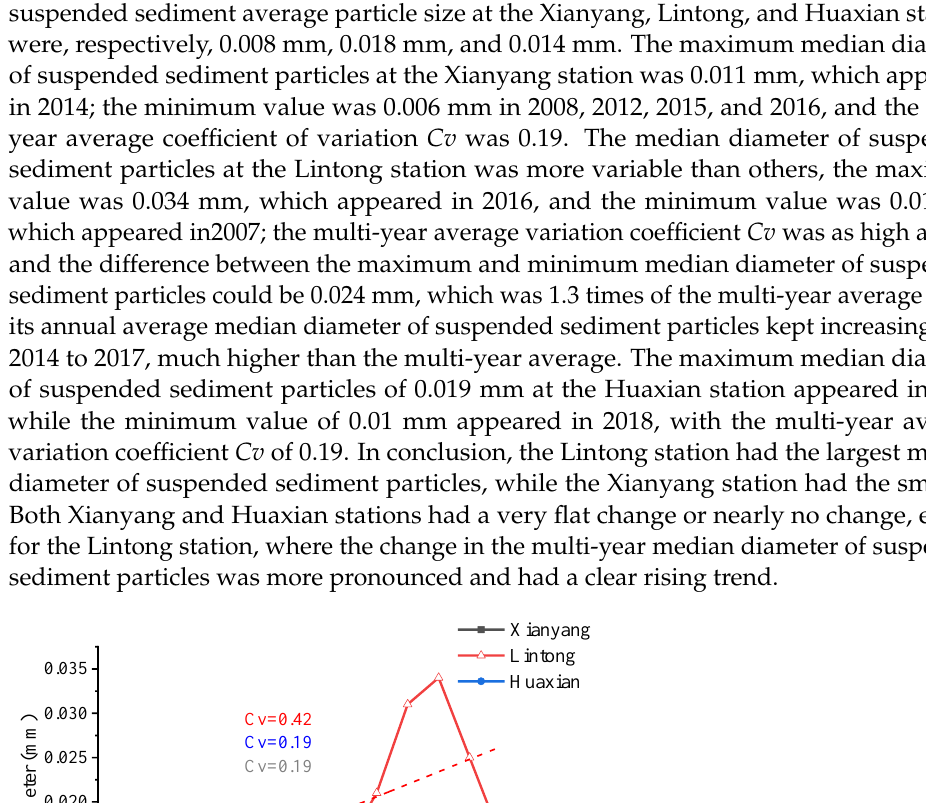
Table 4. Typical flood main streamflow and sediment data.